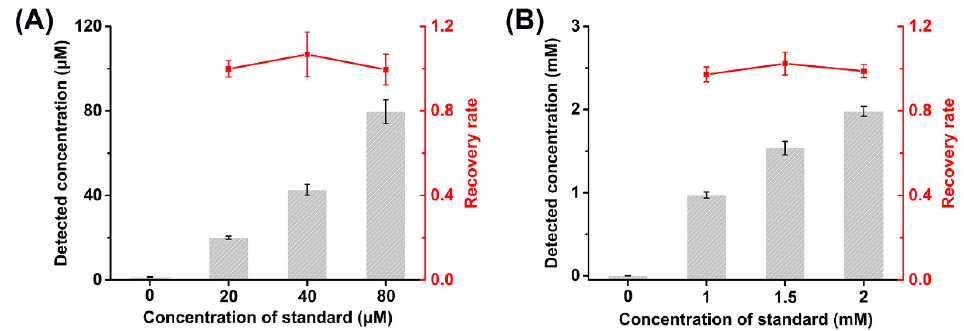
Figure 5. Recovery tests of ( A ) fetal bovine serum and ( B ) artificial urine.